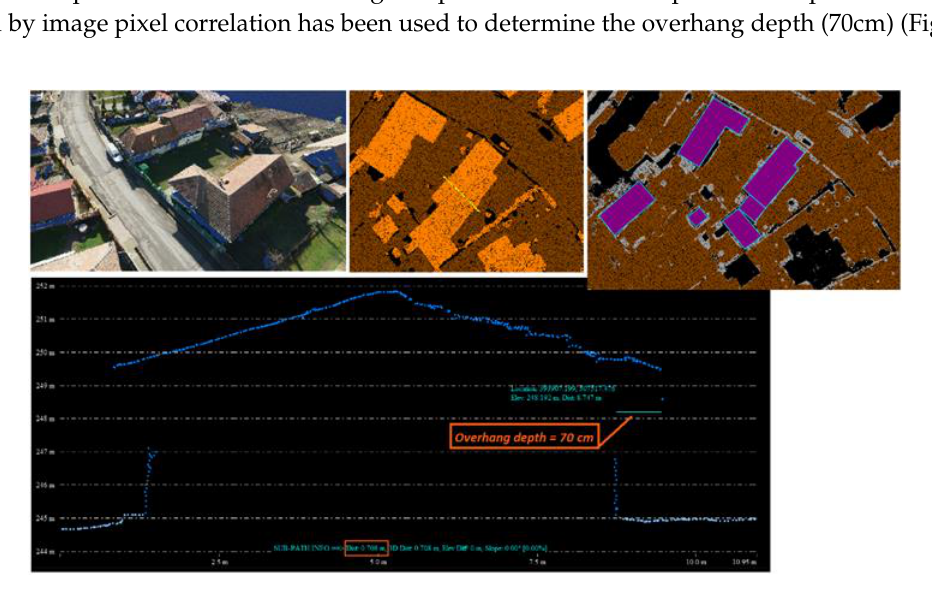
Figure 14. Crowdsourced cadastral data. ( a ) Caracal city center and ( b ) Ciugud village build-up area. Following the completion of the field procedures, a 5-days campaign of classical survey measurements was realized in both areas, in order to verify the correctness of the acquired crowdsourced data. The measurements were realized with the Leica TS 02 total station. The comparison of the two datasets presents that the crowdsourced cadastral data set are within the official accuracy for the cadastral surveying according to the Romanian NCMA’s specifications (RMSxy for urban areas is 0.4 and the RMSxy for the non-build-up areas is 1.0 m) (Figure 15).